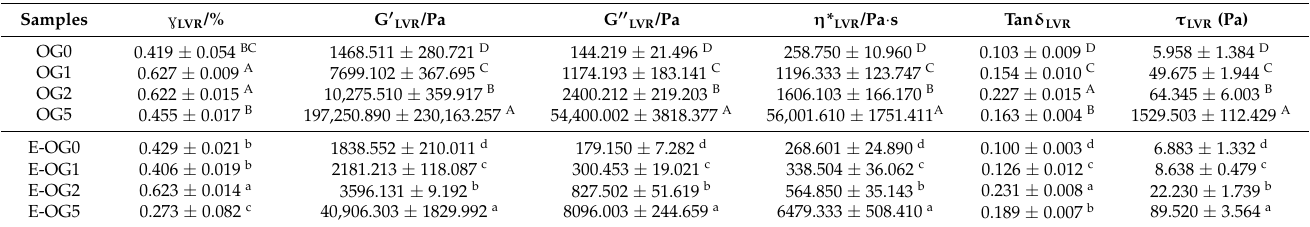
Figure 4. Macro-morphology and Microstructures of W/O emulsions with different content of GMS.